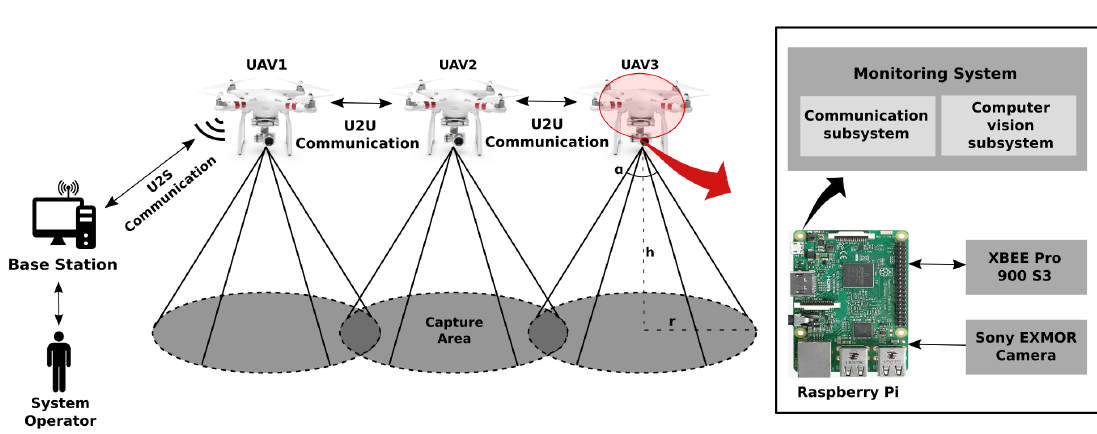
Figure 6. Architecture for the Multi-UAV